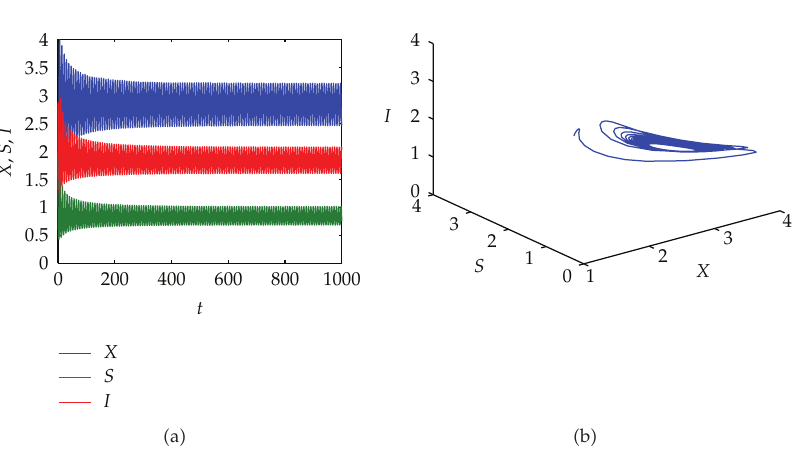
Figure 2: When τ (cid:5) 1 . 13 > τ 0 , bifurcation periodic solutions form E (cid:8) . (cid:6) a (cid:7) shows the trajectory graphs of system (cid:6) 4.1 (cid:7) with initial data x (cid:6) t (cid:7) (cid:5) 2 , y 1 (cid:6) t (cid:7) (cid:5) 2 , y 2 (cid:6) t (cid:7) (cid:5) 2. (cid:6) b (cid:7) shows the phase portrait of system (cid:6) 4.1 (cid:7)